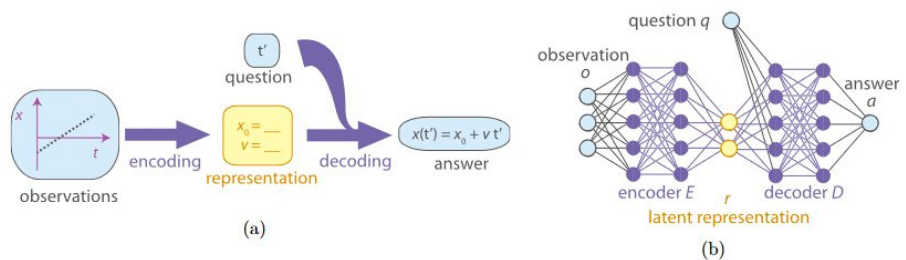
Figure 7. Learning physical representations. ( a ) Human problem analysis. Experimental observations are compressed into a simple representation (encoding). If any question is asked about the physical setting, the human should be able to produce a correct answer using only the representation and not the original data. The process of producing the answer (by applying a physical model to the representation) is called decoding; ( b ) Neural network structure for SciNet. Observations are encoded as real parameters fed to an encoder (a feed-forward neural network), which compresses the data into a representation (latent representation). The question is also encoded in a number of real parameters, which, together with the representation, are fed to the decoder network to produce an answer [51].